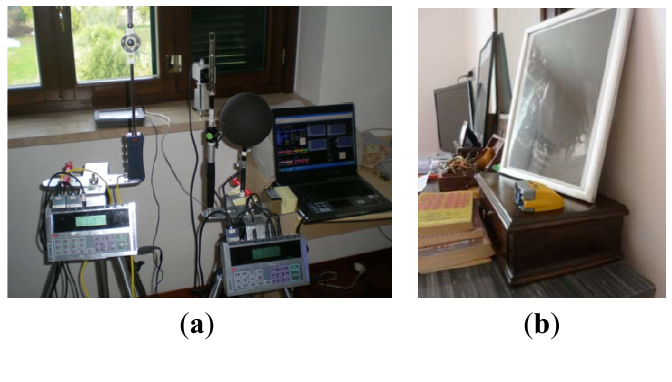
Figure 3. ( a ) Multi channel systems and probes during the acquisition in a selected room; and ( b ) temperature and relative humidity sensors (red circle) in other